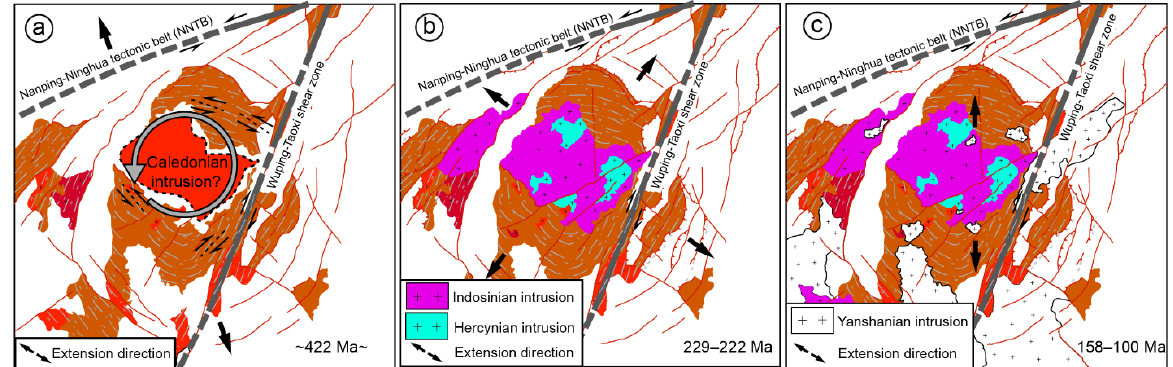
Figure 19. Simplified geological two-dimensional map showing the multi-stage evolution of the Taoxi dome. ( a ) Anticlockwise rotated deformation of the Precambrian basement in the Taoxi dome at about 422 Ma. ( b ) Widespread intrusion in the core of the Taoxi dome at 229–222 Ma. ( c ) Widespread intrusion around or in the Taoxi dome at 158–100 Ma.